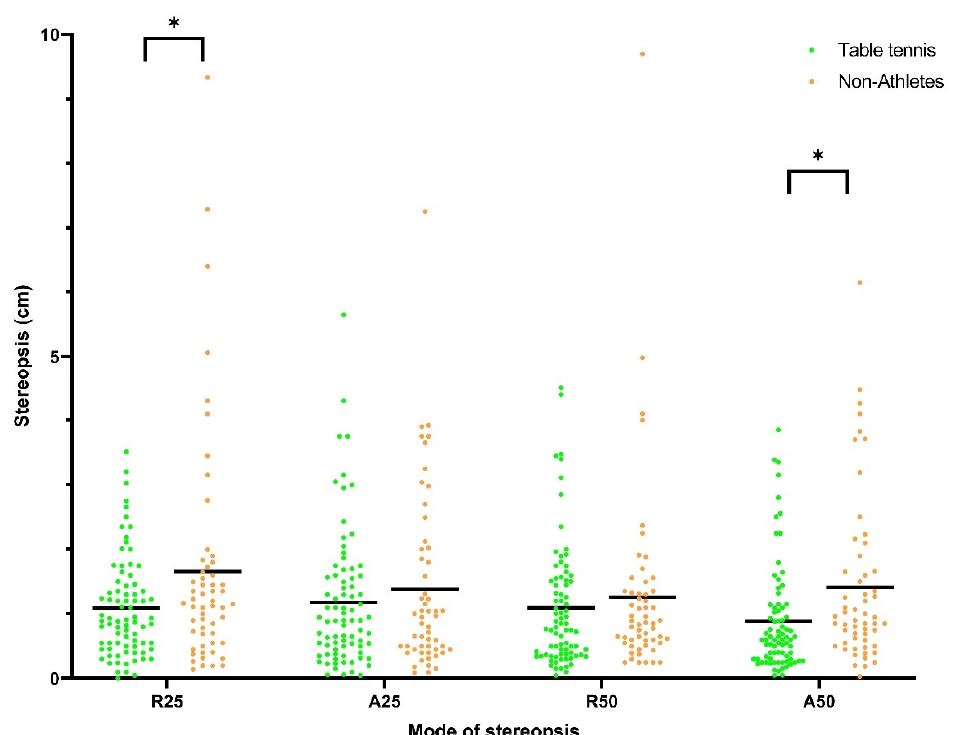
Figure 1. Stereopsis of male and female college students measured in four modes of stereopsis. (*: statistical significant between males and females)